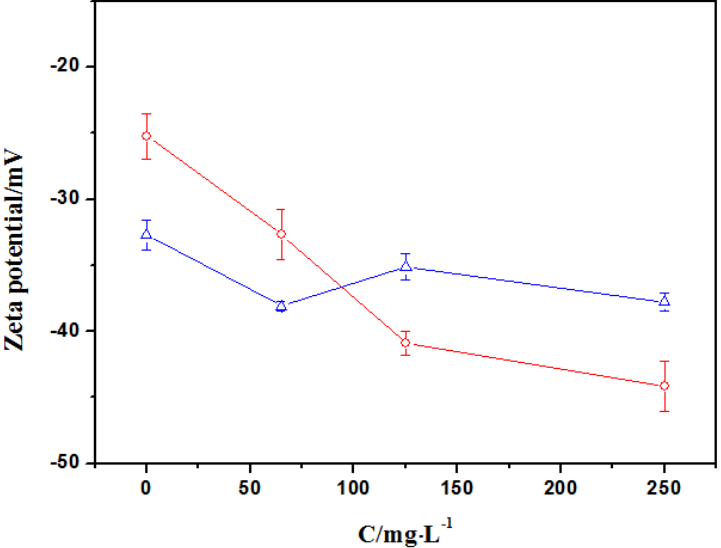
(OH) and C (C(COOH) 60 n 60 (OH) effect; blue line represent C 60 n